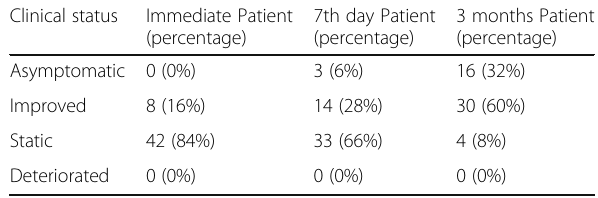
Table 4 Post procedural clinical pain